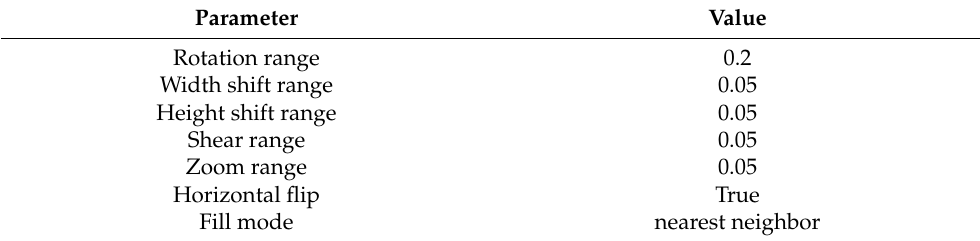
Table 1. Summary of parameters used for data augmentation.